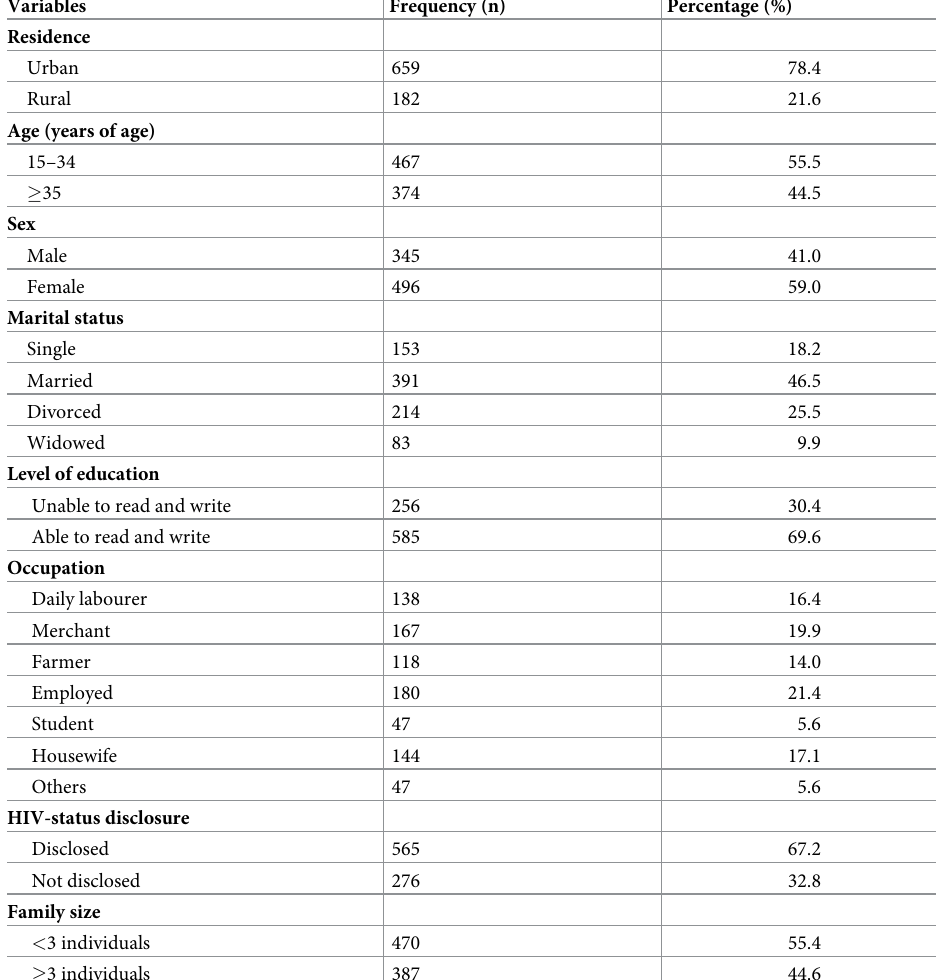
Table 1. Baseline sociodemographic characteristics of adults living with HIV on ART at Debre Markos Compre- hensive Specialized Hospital, Northwest Ethiopia (n = 841).